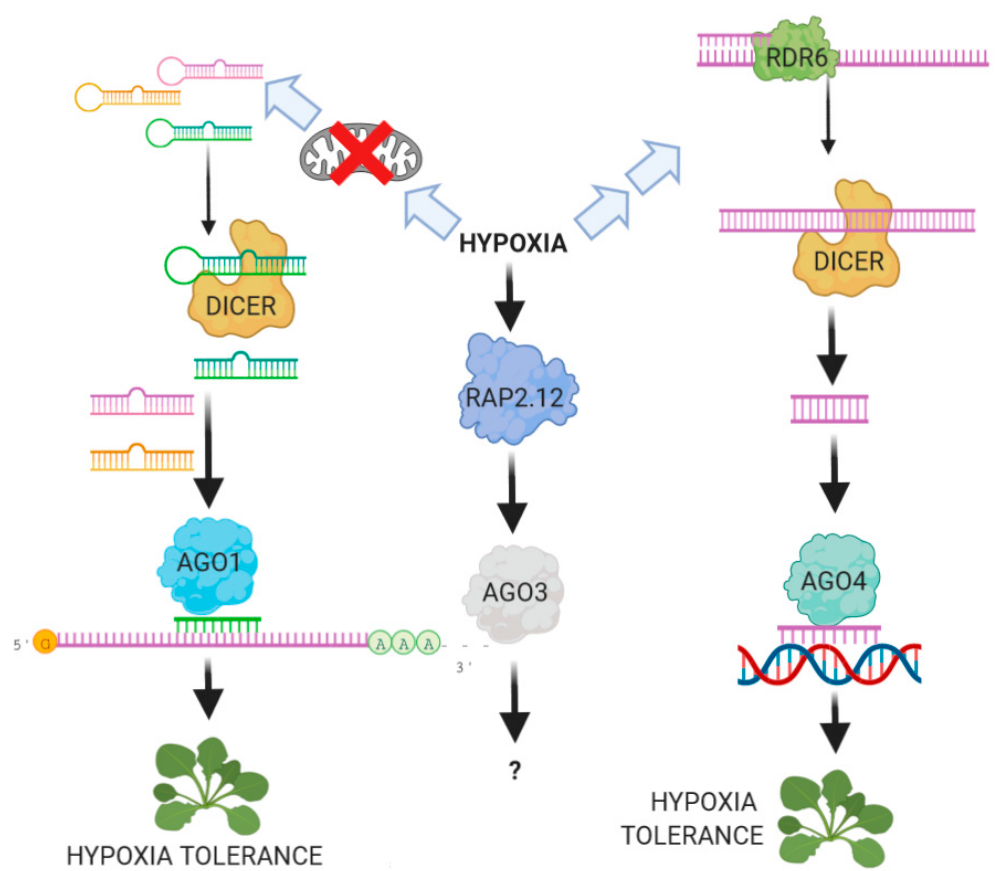
Figure 1. Influence of hypoxia on the RNAi machinery in plants. Under hypoxia mitochondrial activity is largely prevented due to the lack of oxygen. This is likely to be one of the factors triggering the production of some hypoxia-related miRNAs which, by relying on the activity of AGO1, contribute to hypoxia tolerance. Hypoxia tolerance is also influenced by AGO4, which controls RNA-dependent DNA-methylation pathways. The stabilization of the transcription factor RAP2.12 activates the transcription of AGO3, whose role in RNAi is still largely